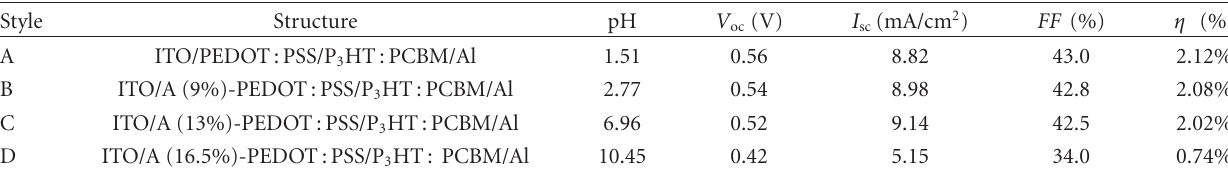
Table 1: PV parameters of OPVs for AW doping.